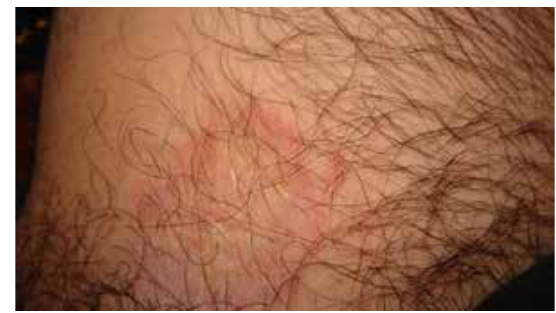
Figure 5. Tinea cruris (Image available from http://forums.menshealth.com/ topic/63643898177459471)